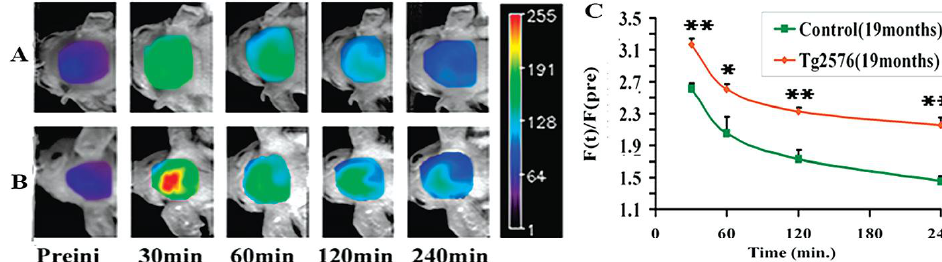
Figure 10. Representative images of Tg2576 mice and control littermates at different time points before and after intravenous injection of 5.0 mg/kg CRANAD-2. ( A ) 19-month-old control mouse; ( B ) 19-month-old Tg2576 mouse (mice showed similar background fluorescence signal); ( C ) the relative fluorescence signal [ F ( t )/ F (pre)] was significantly higher than that of the control mice, and the decay of fluorescence signal was significantly slower in transgenic mice compared with the control group (*: p = <0.005, **: p = <0.01).